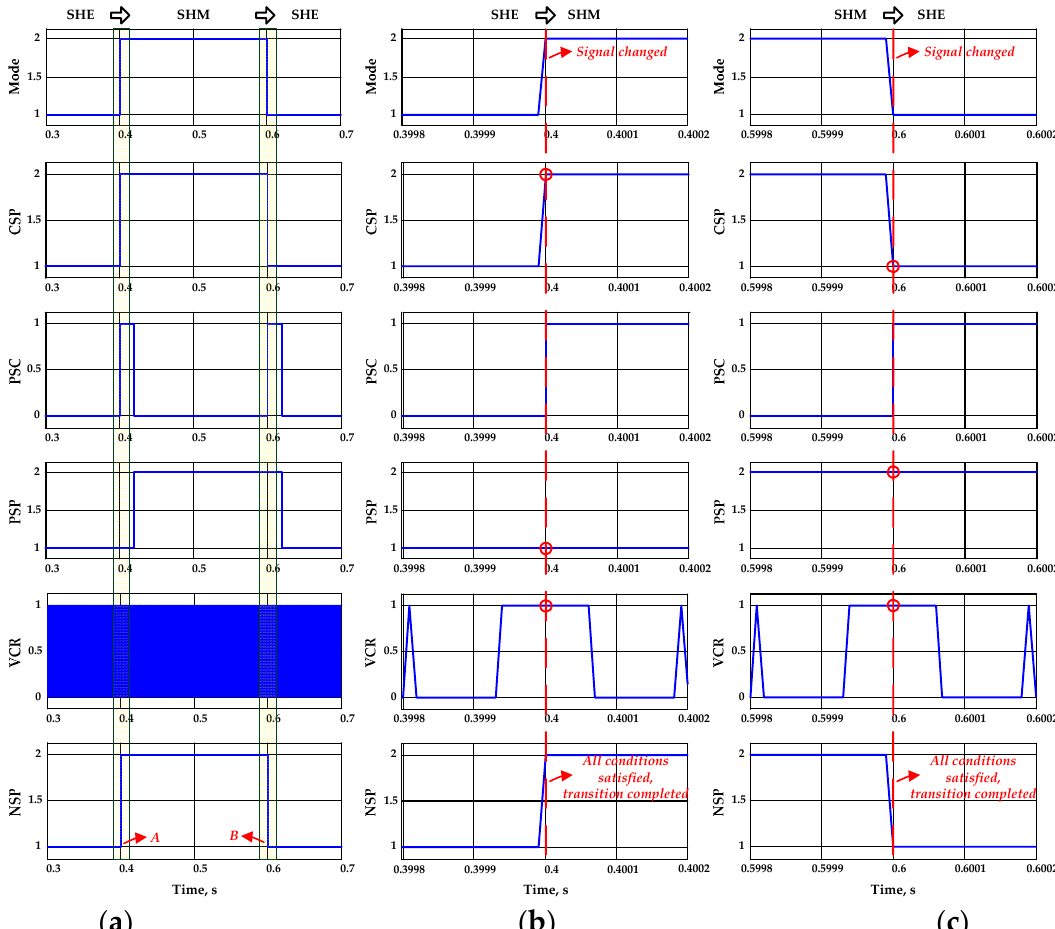
Figure 7. Sequence diagram for proving the proposed transition algorithm: ( a ) Transition between SHEPWM and SHMPWM; ( b ) Zoom A of the transition from SHEPWM to SHMPWM; ( c ) Zoom B of the transition from SHMPWM to SHEPWM.